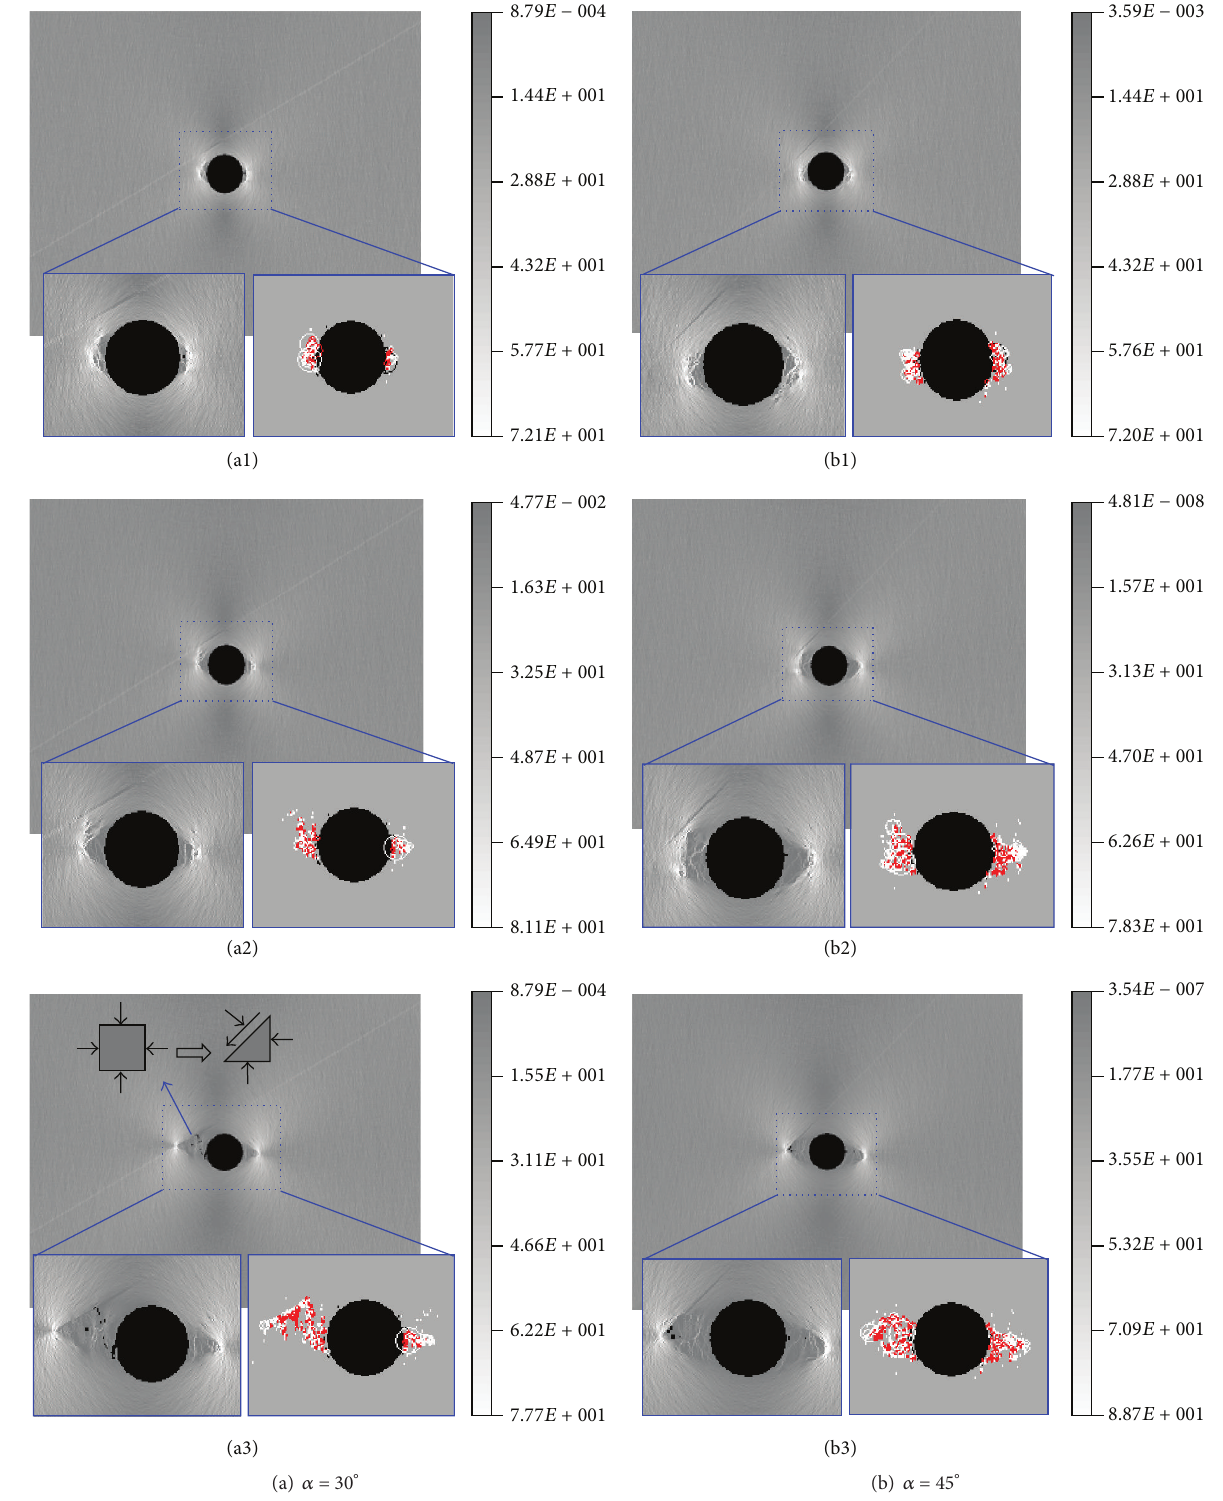
Figure 14: Shear stress and acoustic emission during surrounding rock failure in an underground cavern for different inclinations ( 𝛼 ) of the weak structural plane. (a) Shear stress and acoustic emission distribution during crater formation, 𝛼 = 30 ∘ , and (b) shear stress and acoustic emission distribution during crater formation, 𝛼 = 45 ∘